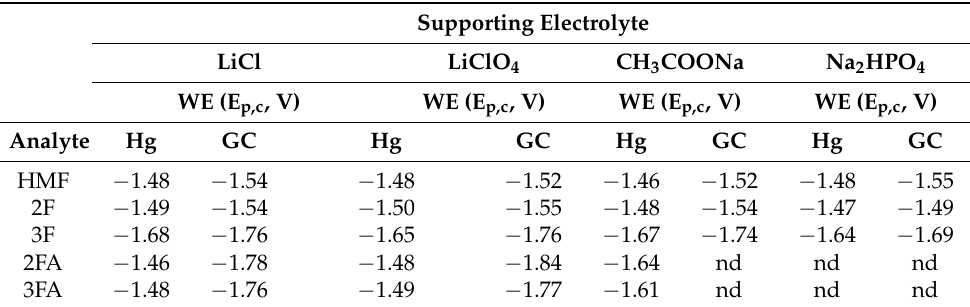
Table 3. Cathodic peak potentials E p,c (V vs. SCE) for HMF, 2F, 3F, 2FA, and 3FA measured in a